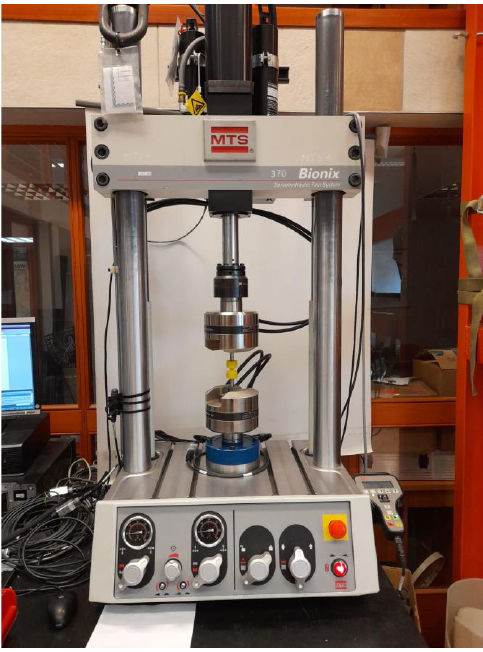
Figure 5. MTS858 Bionix fatigue test stand used for PUR fatigue